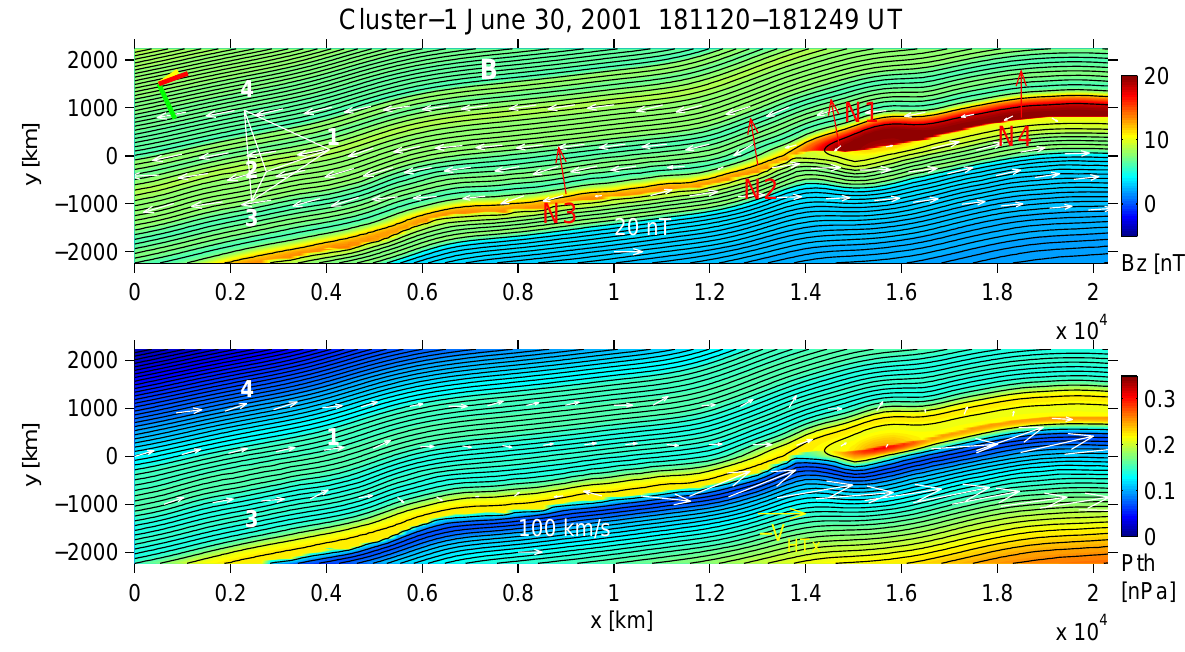
Fig. 3. Magnetic transect (top) and plasma pressure distribution (bottom) obtained by using time-varying HT frame velocity for the C1 magnetopause crossing on 30 June 2001. Contours describe the transverse magnetic field lines. In this reconstruction plane, the spacecraft generally moved from left to right: The magnetosheath, where B x < 0; B y < 0, is on the upper left side and the magnetosphere ( B x > 0; B y > 0) on the lower right side. In the top panel, B z is expressed in color as indicated by the color bar; the four spacecraft tetrahedron configuration is shown by white lines; the measured magnetic field vectors are projected as white arrows along the spacecraft trajectories; the normal vectors, N1 - N4, computed from MVABC, are projected as red arrows. Line segments in the upper left corner are projections of GSE unit vectors, X (red), Y (green), and Z (yellow), onto the x – y plane. In the bottom panel, the plasma pressure is shown in color; the ion bulk velocity vectors from CIS/HIA (C1 and C3) or CIS/CODIF (C4), transformed into the accelerating HT frame, are projected as white